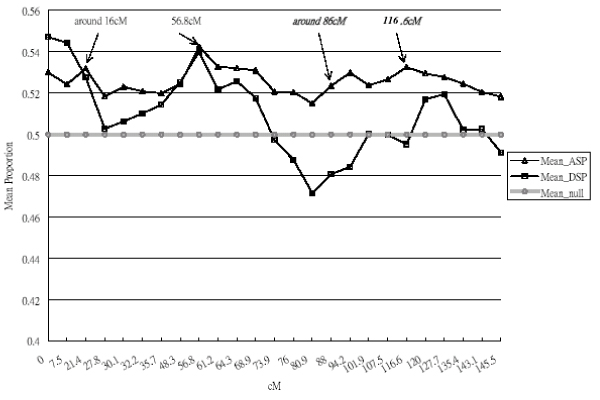
Mean proportion of alleles shared (0*f0+(0.5)*f1+1*f2) by ASPs and DSPs, chromosome 7.